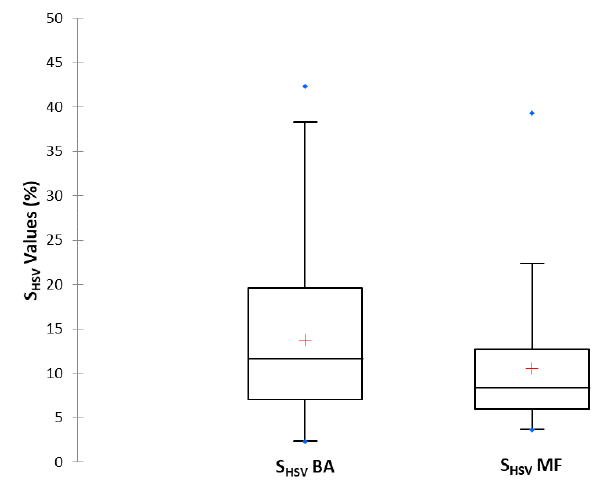
Figure 10. Box-plot of S HSV values obtained from Badajoz and Monfragüe monitoring stations for total days of 2015.